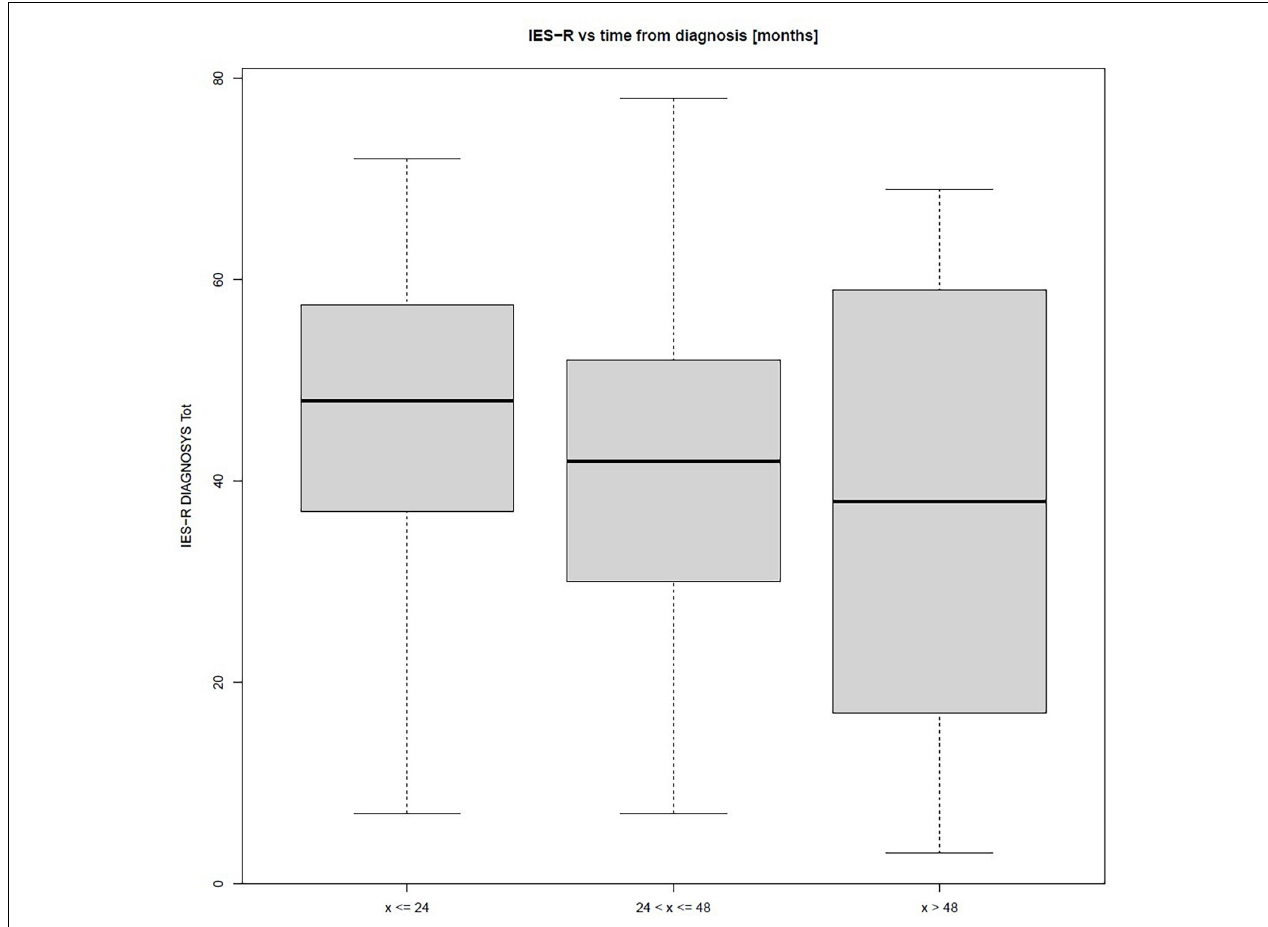
FIGURE 2 | Time from diagnosis and Impact of Event Scale-Revised (IES-R)